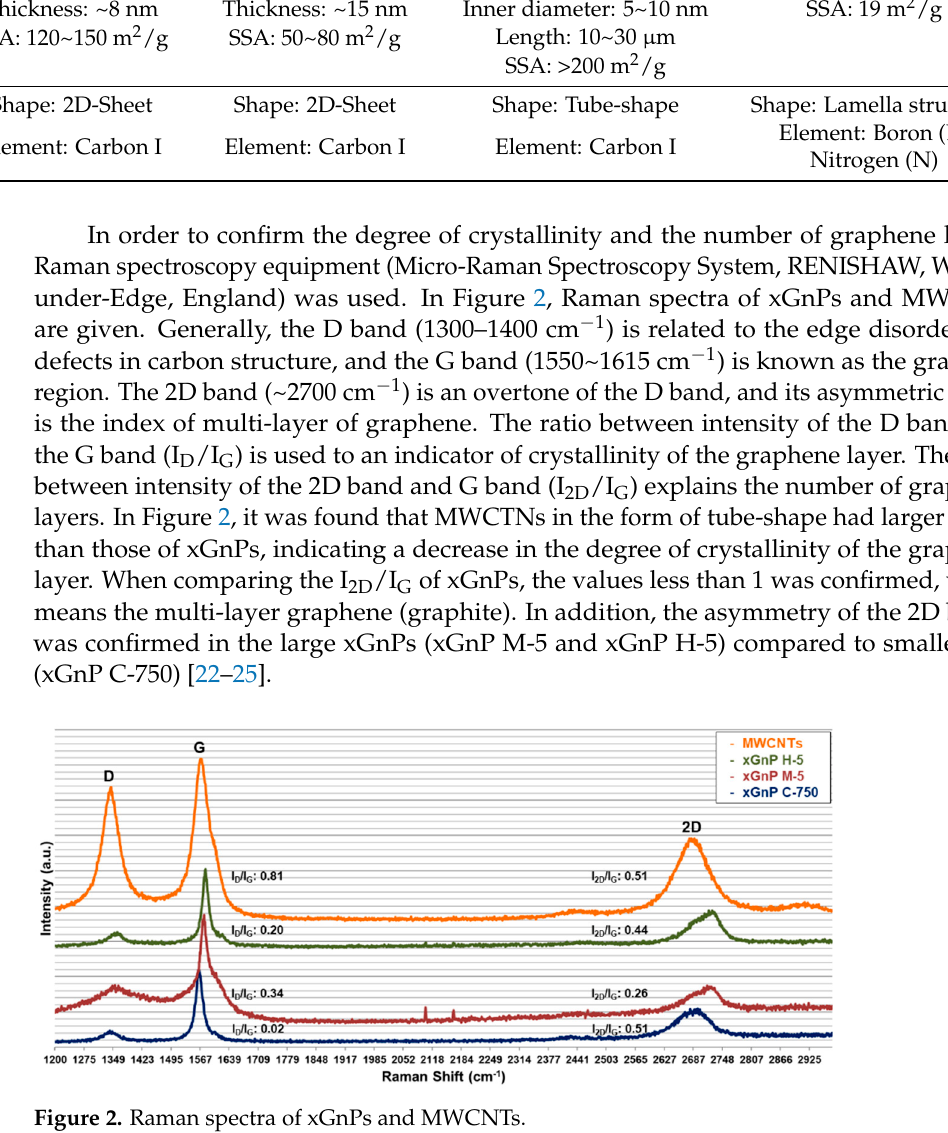
Figure 2. Raman spectra of xGnPs and MWCNTs